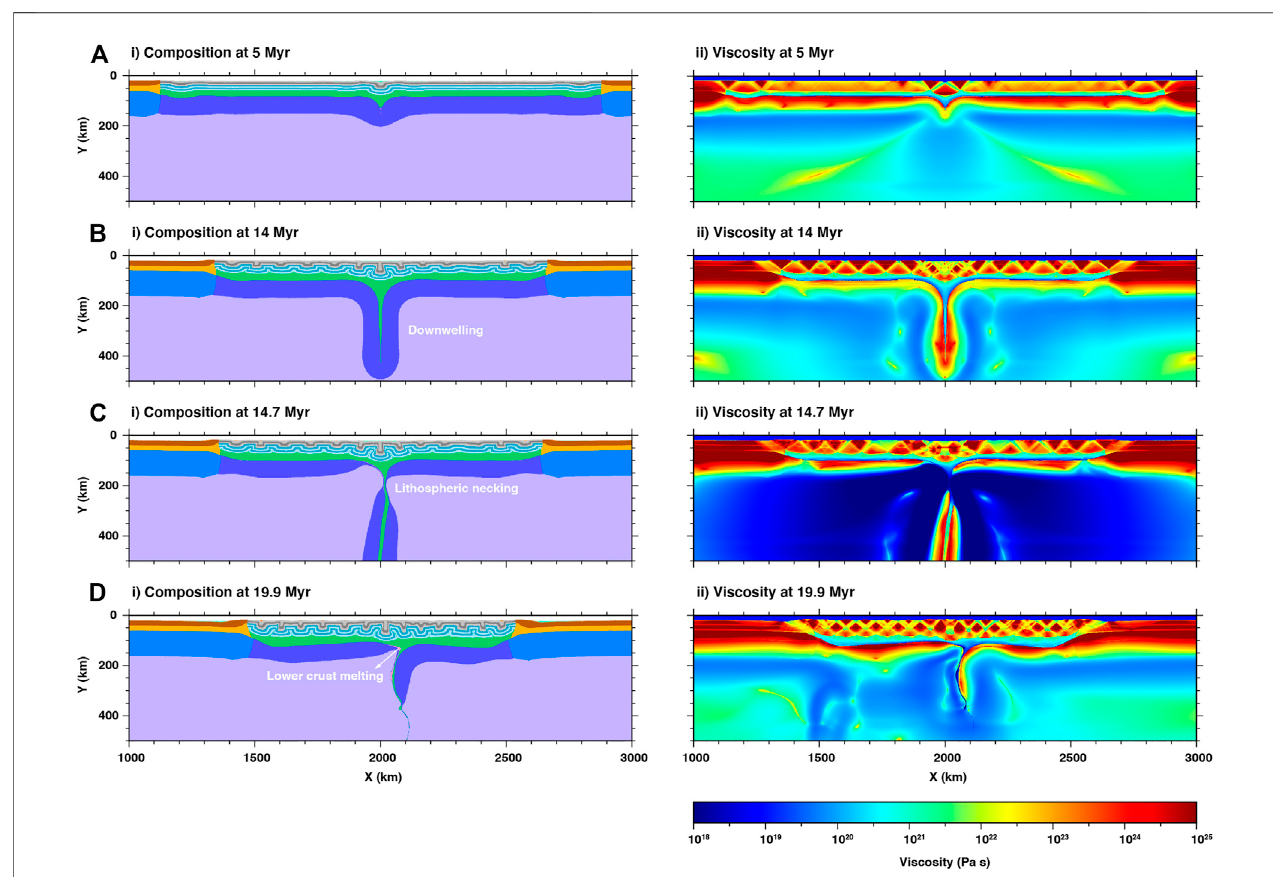
FIGURE3| Timeevolutionofthemodel “ dela ” ,inwhichtheorogenlowercrust rheologyisrepresented bythe fl owlaw ofdiorite. (Ai – Di) compositionevolutionfor selectedmodeltimes(colorsasin Figure2 ). (Aii – Dii) viscositydistributionforselectedmodeltimes.Notetheextremelylowviscosityintheuppermantleshownin (Cii) is due to the presence of very large velocities as the downwelling breaks off.